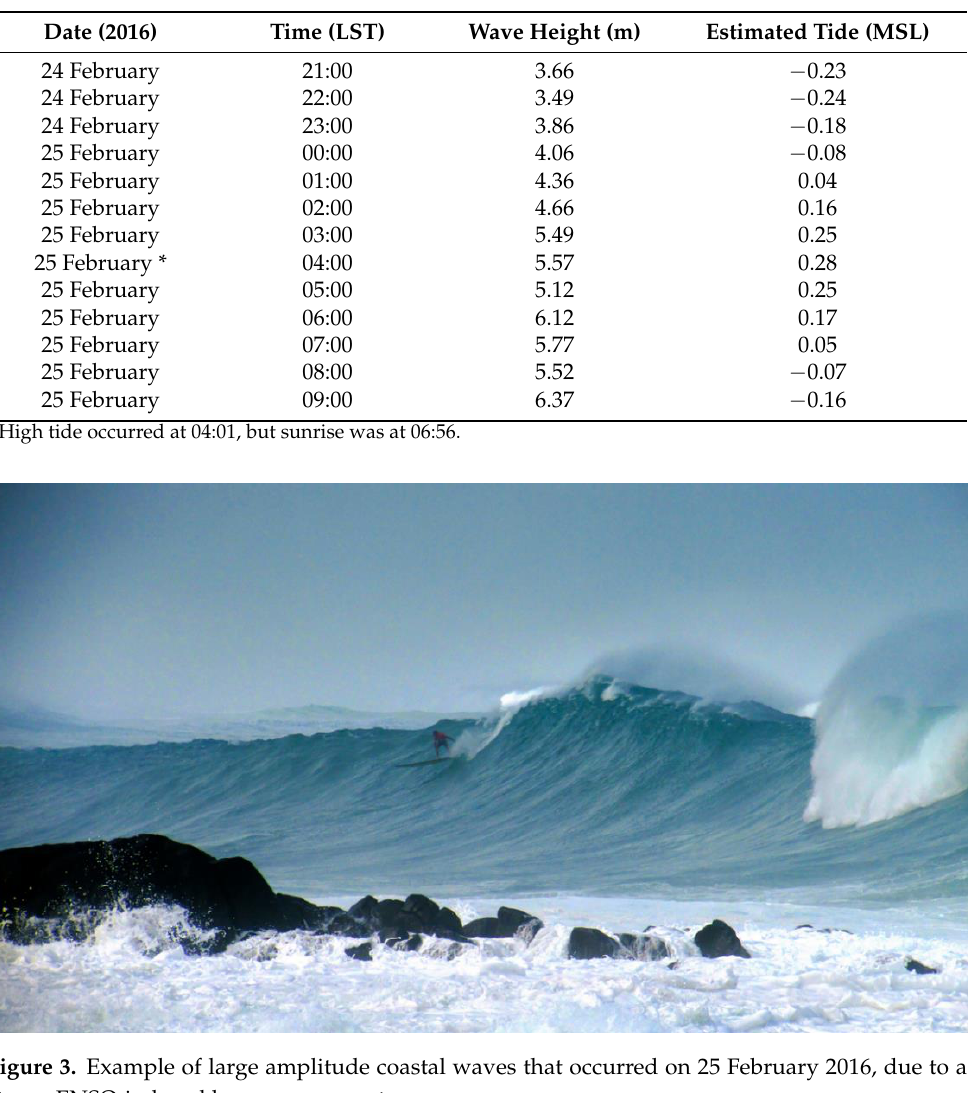
Table 1. Wave height data for the North Shore of Oahu (NOAA Buoy #51202) and local tide data at Laie Point (NOAA Station #1612480) for 24 – 25 February 2016. High tide and extreme wave heights coincided around 04:00 local time, which is the most likely time for extreme erosion at Laie Point and Kukuiho’olua Island (shaded rows). LST = Local Standard Time. MLS = Mean Sea Level.